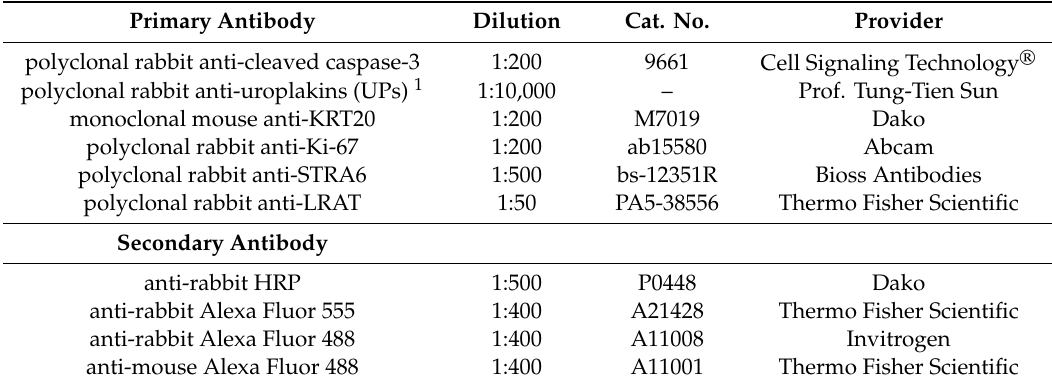
Table 2. List of primary and secondary antibodies used for immunolabeling. Primary Antibody Dilution Cat.